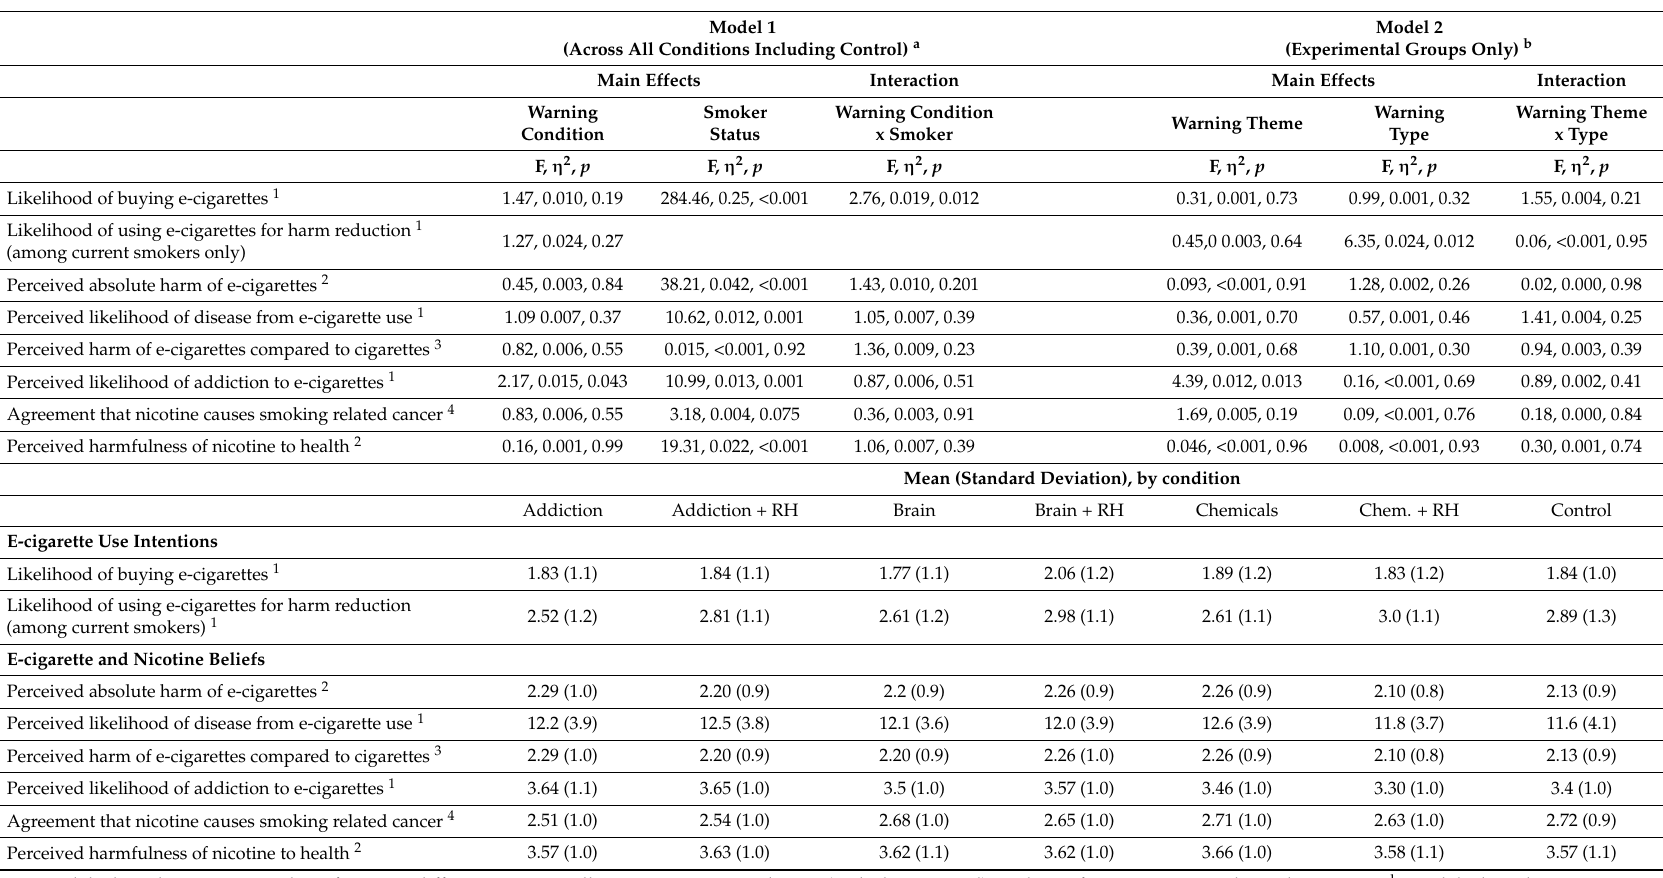
Table 2. Impact of Experimental Conditions on E-cigarette Use Intentions, E-cigarette Beliefs and Nicotine Beliefs (n =